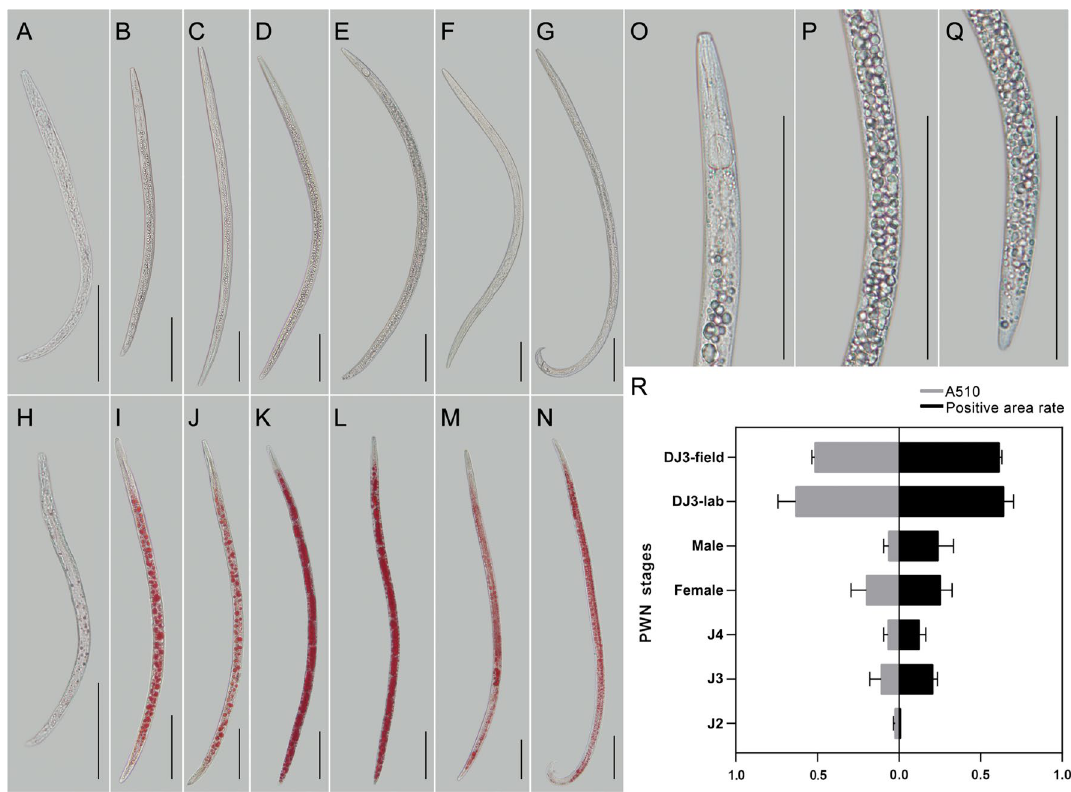
Figure 1. Morphological characteristics of different stages of PWNs. ( A – G ) Microscopy of J2, J3, J4, DJ3-lab, DJ3-field, Female, and Male. ( H – N ) Oil-Red-O stained J2, J3, L4, DJ3-lab, DJ3-field, Female, and Male. ( O – Q ) Details of DJ3-lab. ( R ) Comparison of the lipid content between different stages of PWNs, as determined by Oil- Red-O staining. Bars indicate 100